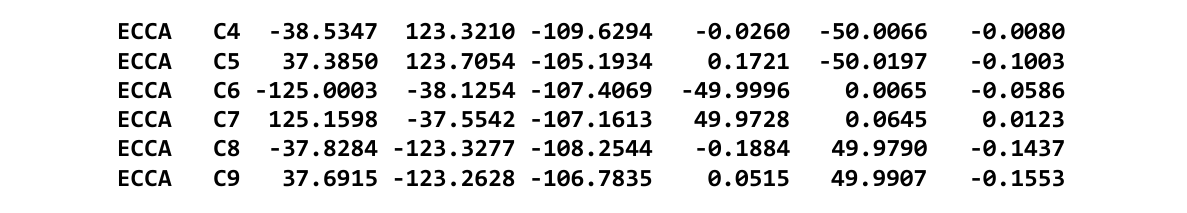
Table 2: Important result from geometric laboratory calibration: Eccentricity vectors for each